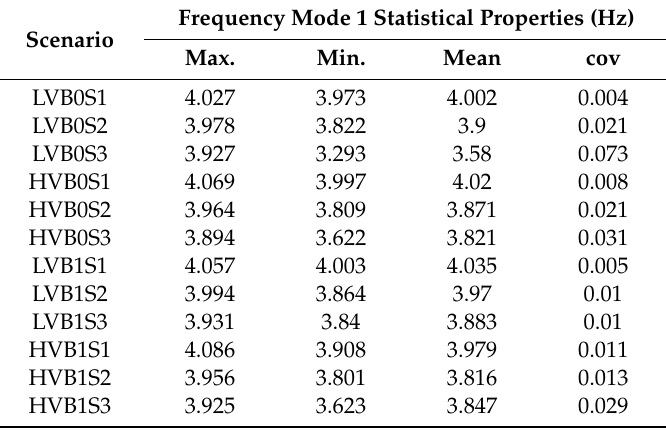
Table 8. Fundamental frequency for each